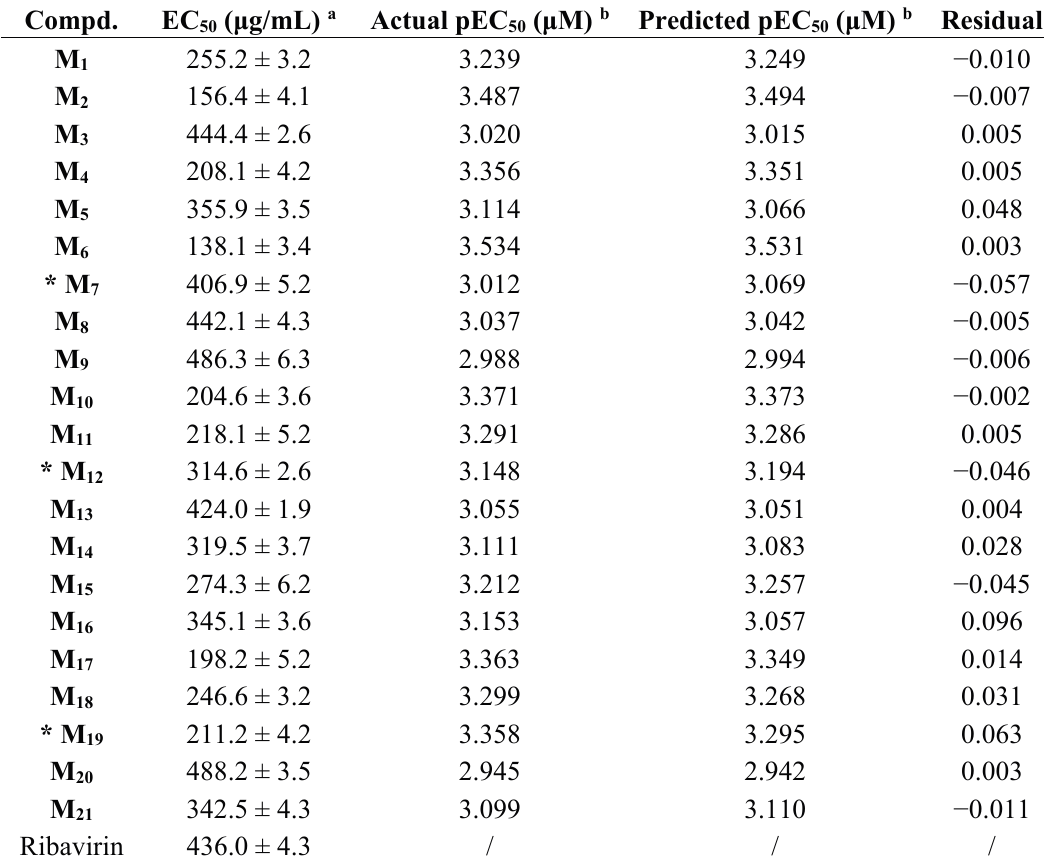
Table 2. Actual and predicted protection activities against